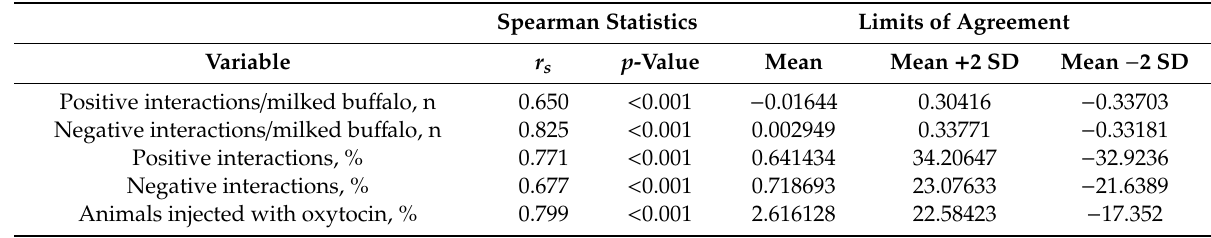
Table 1. Test–retest reliability of the variables observed on the stockpeople using Spearman rank correlation coe ffi cient ( r s ) and limits of agreement (mean of di ff erences ± 2 SD). Calculations were based on two farm visits (n = 27).